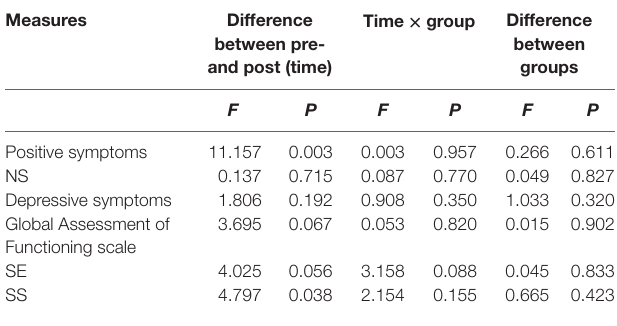
TaBle 4 | ANOVA of repeated measures.